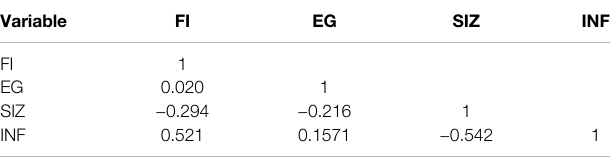
TABLE 4 | Correlation results. TABLE 5 | Estimation results regarding impact of fi nancial innovation, economic growth, size, and in fl ation on the credit